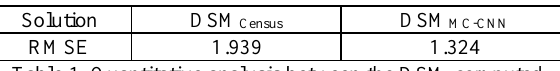
Table 1. Quantitative analysis between the DSM computed from the selected matching cost computation methods and the LiDAR-DSM (meter).